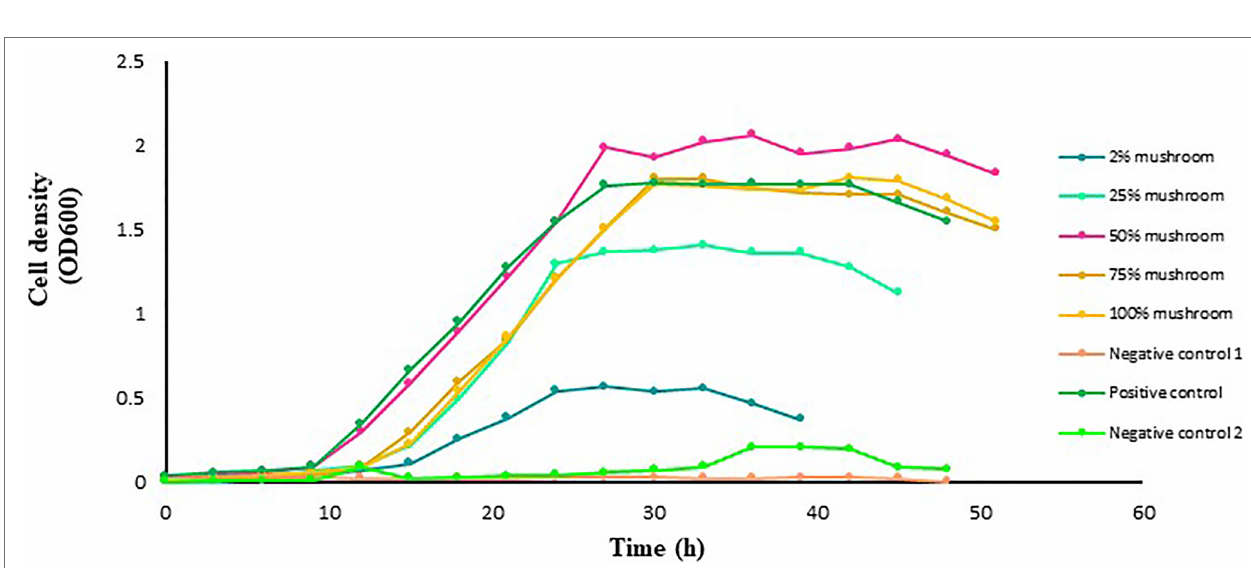
FIGURE 4 | Growth of L. delbrueckii subsp. bulgaricus in MRS broth medium with and without mushroom extract added at an increasing concentration of 2, 25, 50, 75, or 100%. Lactobacillus acidophilus grown in MRS broth medium with a standard amount of glucose served as a positive control. The glucose-free MRS medium with 100% of mushroom extract and without L. acidophilus served as negative control 1. The MRS medium free from both glucose and extract but with L. acidophilus served as negative control 2. The data points are the mean values of three